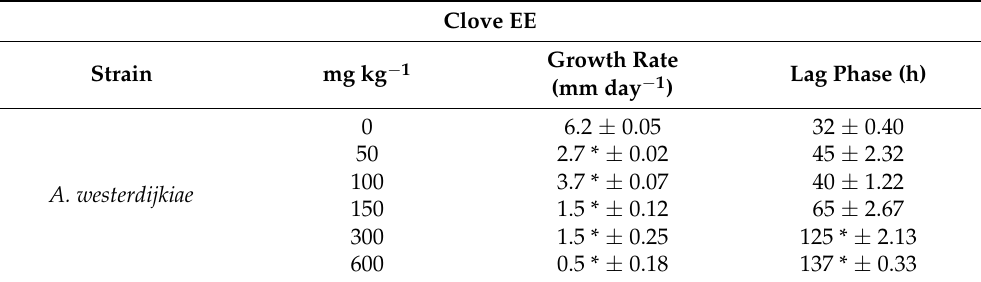
Table 8. Effect of clove ethanolic extract on lag phase and growth rate of A. westerdijkiae at differ- ent concentrations.